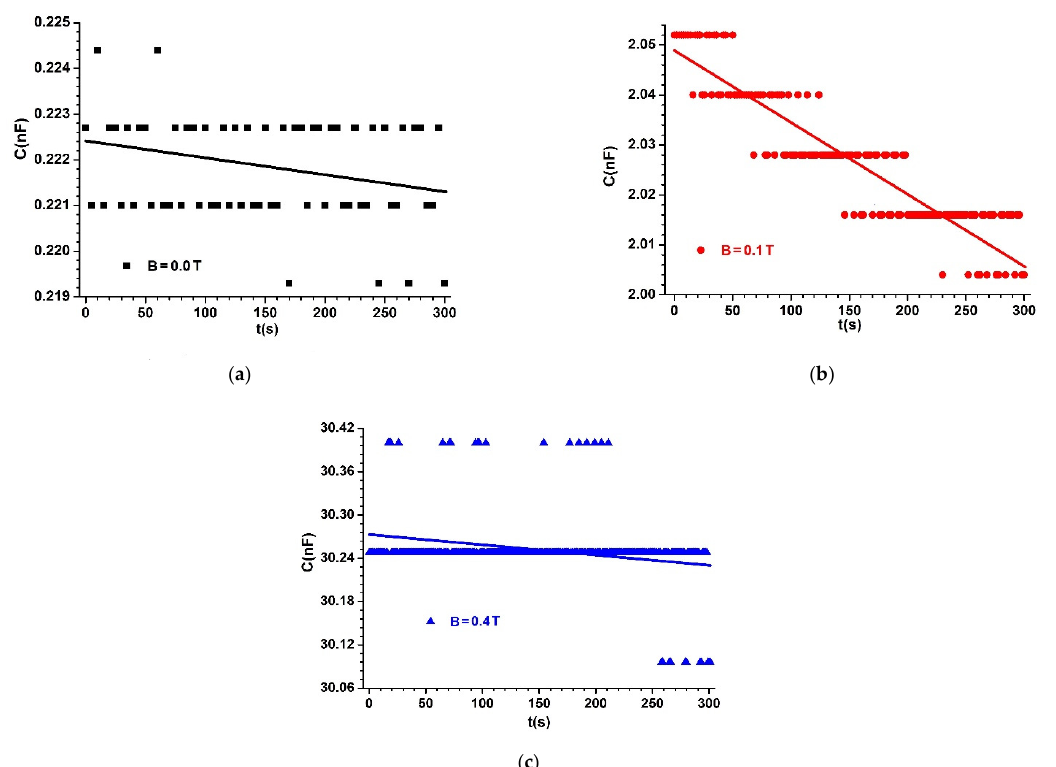
Figure 7. Electric capacitance of MC 2 capacitor placed in a magnetic field with magnetic flux density of: ( a ) B = 0.0 T; ( b ) B = 0.1 T; ( c ) B = 0.4 T. Dots are experimental data and lines indicate linear fit.